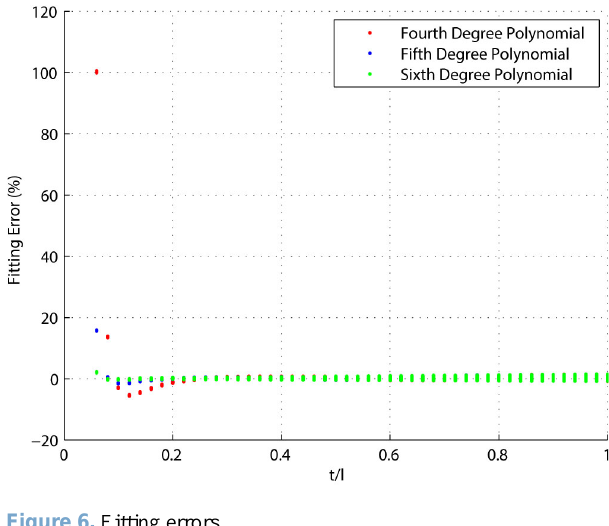
Figure 6. Fitting